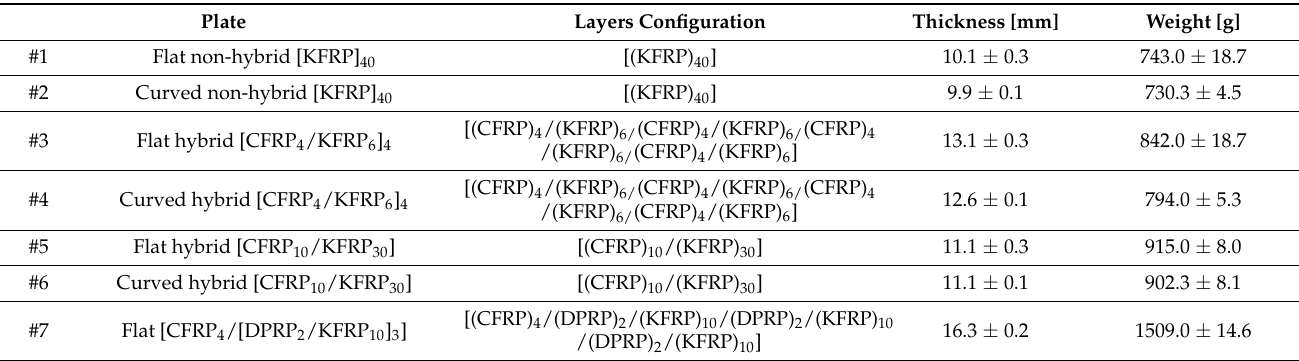
Table 1. Specifications of the fabricated plates, carbon fiber reinforced plastic (CFRP), Kevlar fiber reinforced plastic (KFRP), date palm reinforced plastic (DPRP).